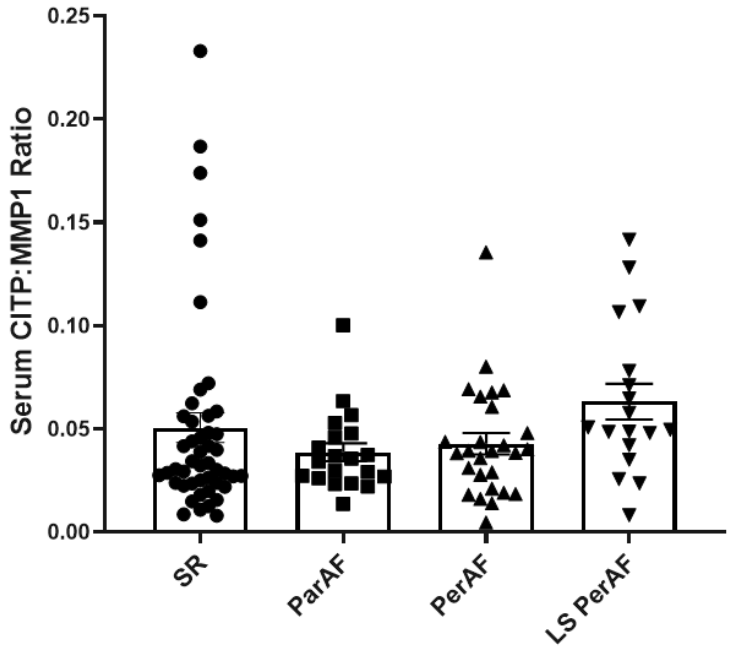
Figure 5. Blood based quantification of ratio CITP/MMP1. Ratio between the sub product of collagen degradation (CITP) and its promoter (MMP1) was assessed (N = 20, ParAF; N = 27, PerAF; N = 18, LS PerAF; and N = 47, SR) in line with the previous endpoints comparable values were observed at different stages of the AF and control SR group, p = 0.07. SR = control group, ParAF = paroxysmal atrial fibrillation, PerAF = persistent atrial fibrillation, LSPerAF = longstanding persistent atrial fibrillation. Statistical tests used: ANOVA.